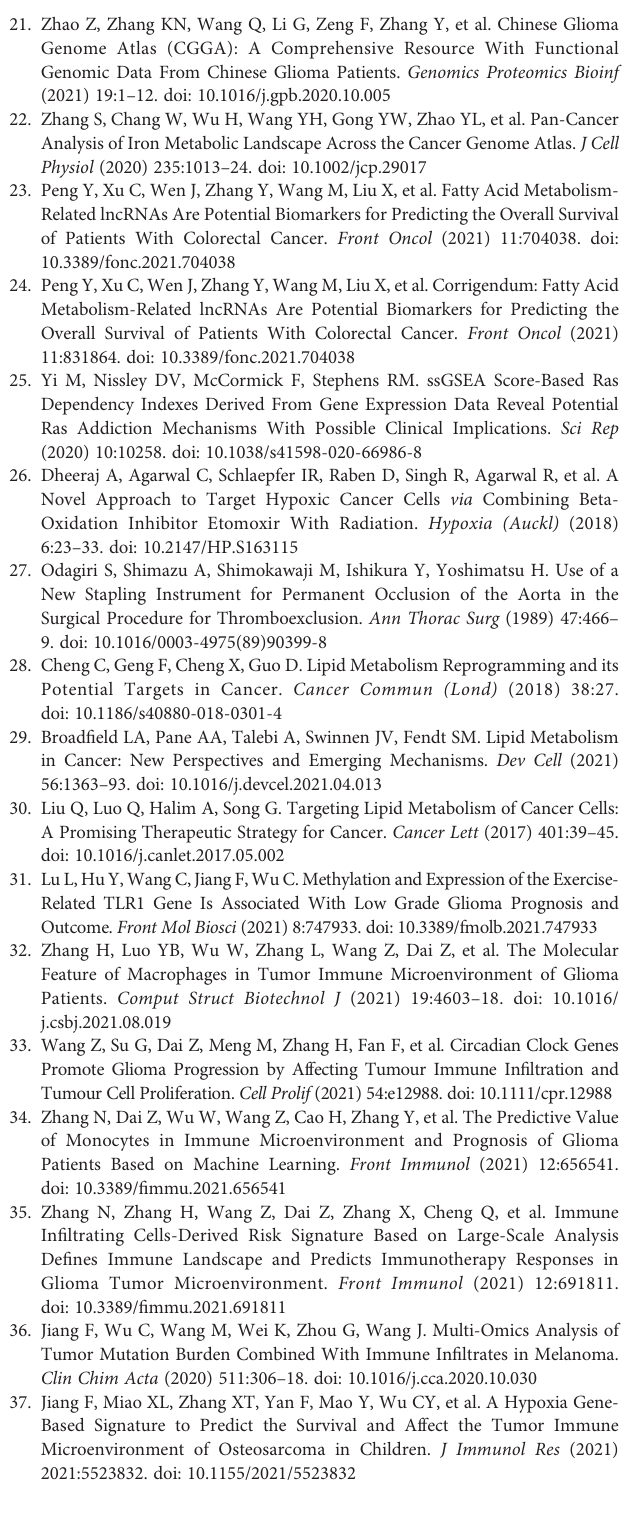
Supplementary Table 3 | 133 genes associated with prognosis after univariate cox